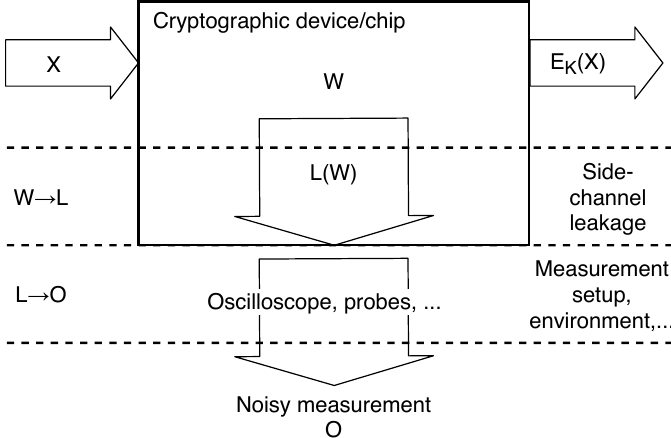
Figure 6. Illustration of channels involved in side-channel